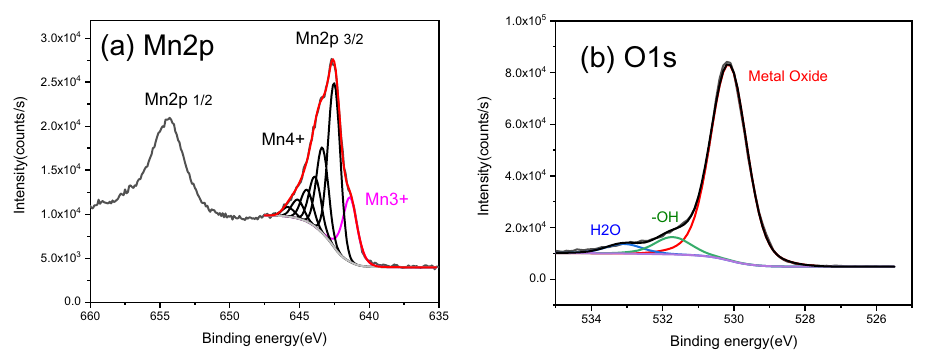
Figure 4. Mn2p ( a ) and O1s ( b ) XPS core level spectra of the synthesised MnO 2 nanomaterial. The spectra are fitted after a proper Shirley background subtraction. The Mn2p 3/2 component is fitted due to the multiple splitting and the corresponding overlapping in binding energy ranges. The pink curve indicates the Mn3 + and the rest 6 black curves represent the Mn4 + oxidation state. O1s was fitted with three components corresponding to the Metal oxide, the –OH and the H 2